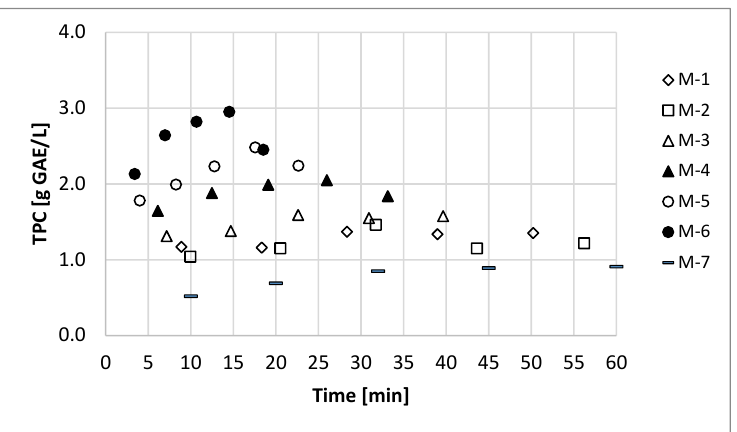
Figure 4. Extraction kinetics at medium scale. Pressurized tests (full), non-pressurized (empty).